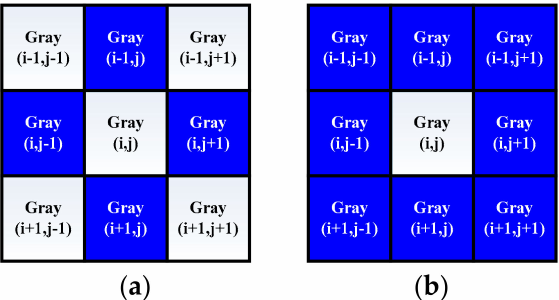
Figure 9. Illustration of the neighborhood expansion methods, ( a ) 4-neighborhood expansion, ( b ) 8-neighborhood expansion.